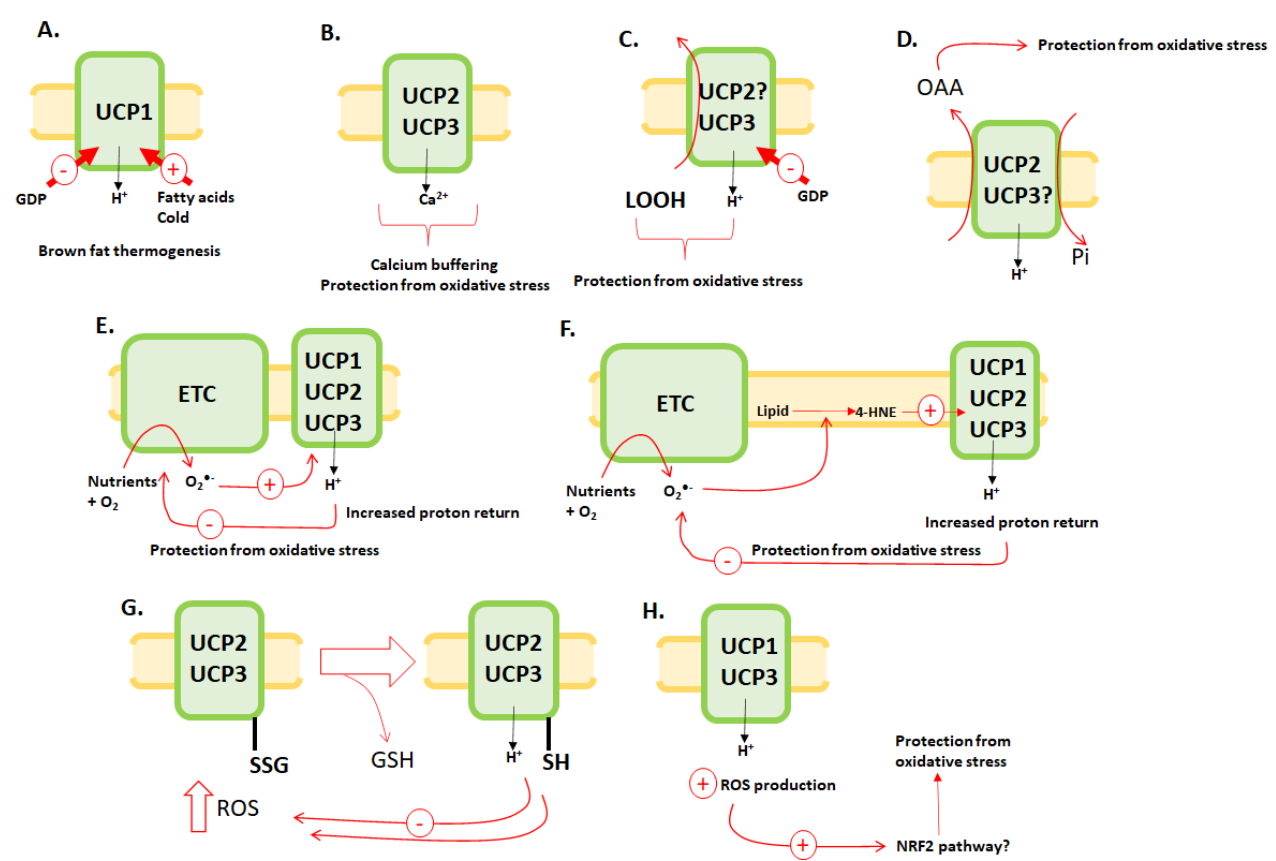
Figure 1. Flow chart depicting the literature screening method.